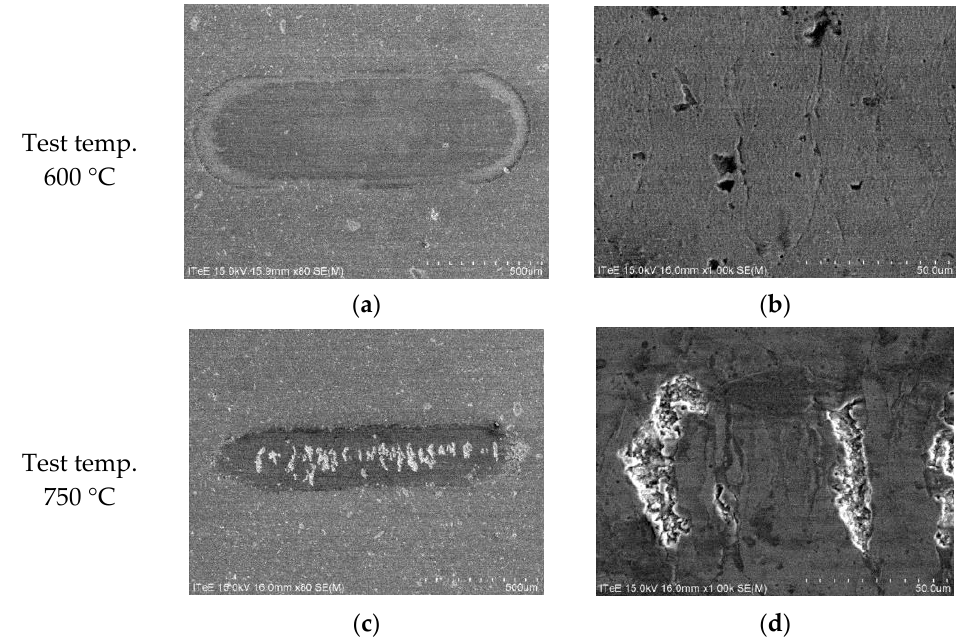
Figure 11. SEM micrographs presenting an overview of the contact zone on the disc made of Group III (Ti-B) composite with AlCrN coating, sintering temp. 1250 °C: ( a ) 600 °C; ( b ) a magnified view, 600 °C; ( c ) 750 °C; ( d ) a magnified view, 750 °C.